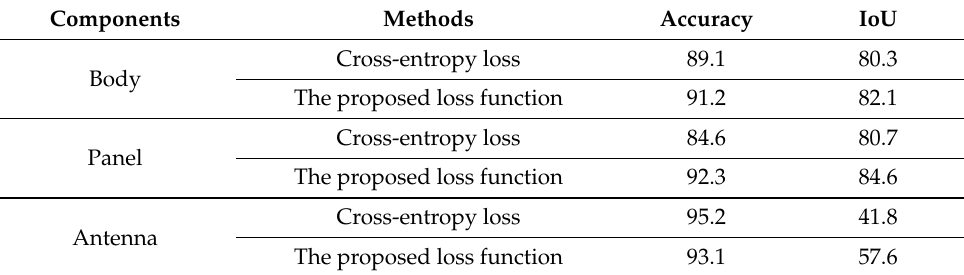
Figure 16. The segmentation error visualization of cross-entropy and the proposed loss function. (red: wrong segmented points; blue: correct segmented points). Table 8. Accuracy evaluations of cross-entropy loss and the proposed loss function